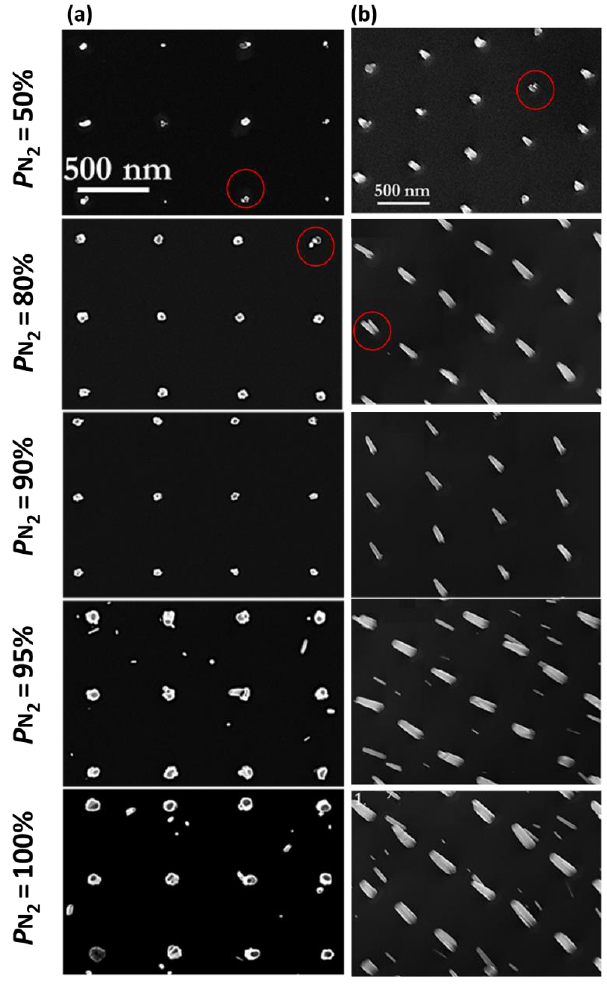
Figure 2. ( a ) Top view and ( b ) 45° bird’s-eye view SEM micrograph of the nanorods with different P N₂ percentages. The red circles indicate where multiple nanorods grow from within a single opening.